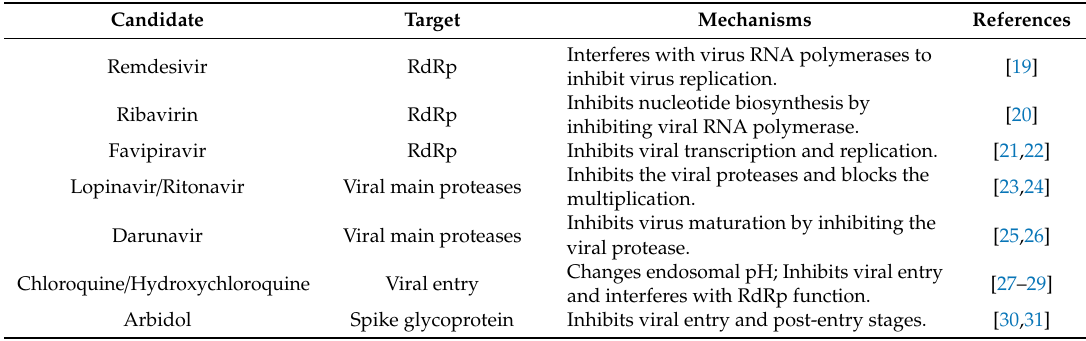
Table 1. List of potential antiviral drugs that may be repositioned towards coronavirus disease 2019 (COVID-19)